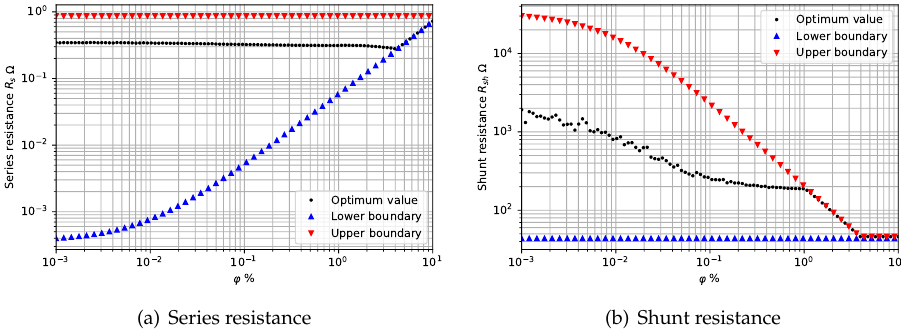
Figure 13. Behavior of the SDM resistances for different values of ϕ . The KC200GT SPVM is